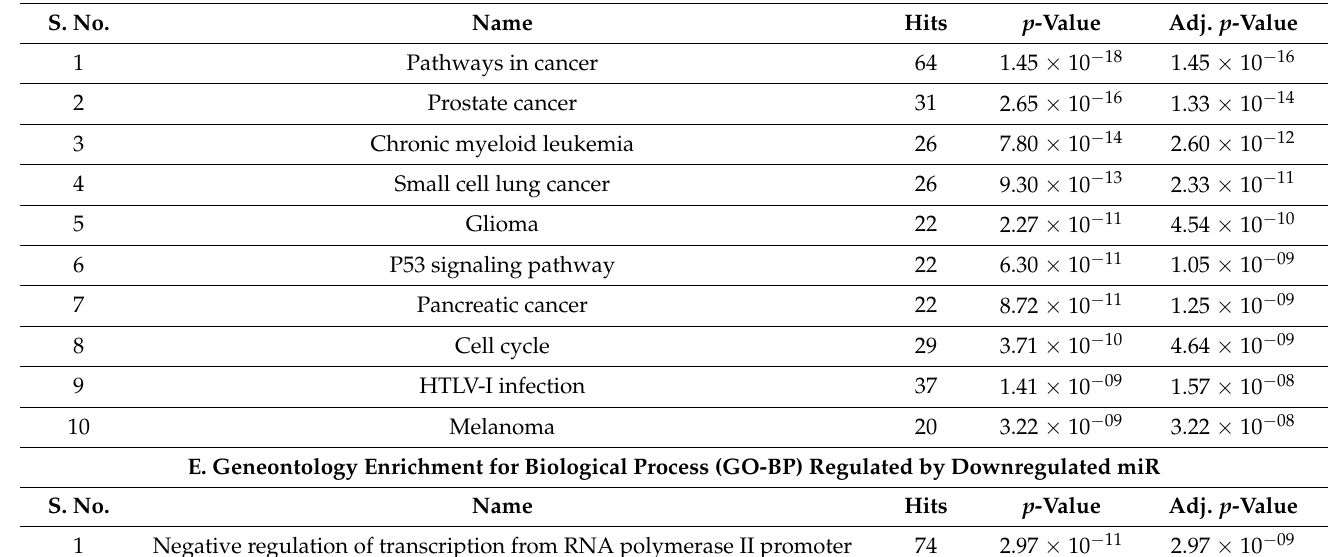
D. KEGG Pathways Regulated by Downregulated